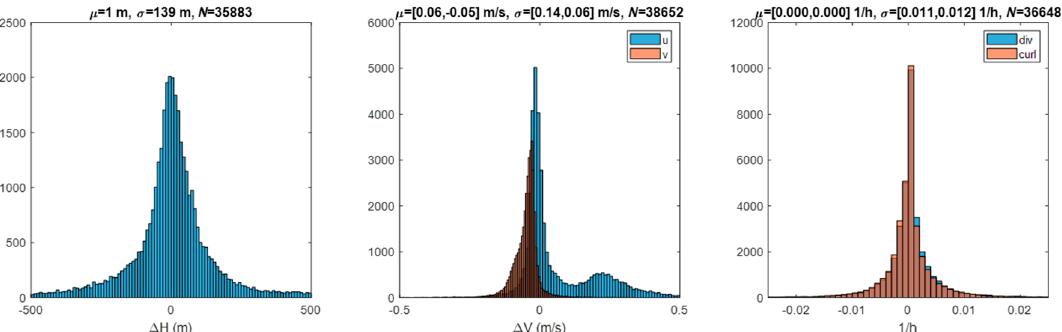
Figure 8. Ground-point retrievals in B07 at 2020/207 17:20 Z from GOES-16 and -17 FDs using a 24 pixel × 24 pixel template and 12 pixel × 12 pixel sampling.